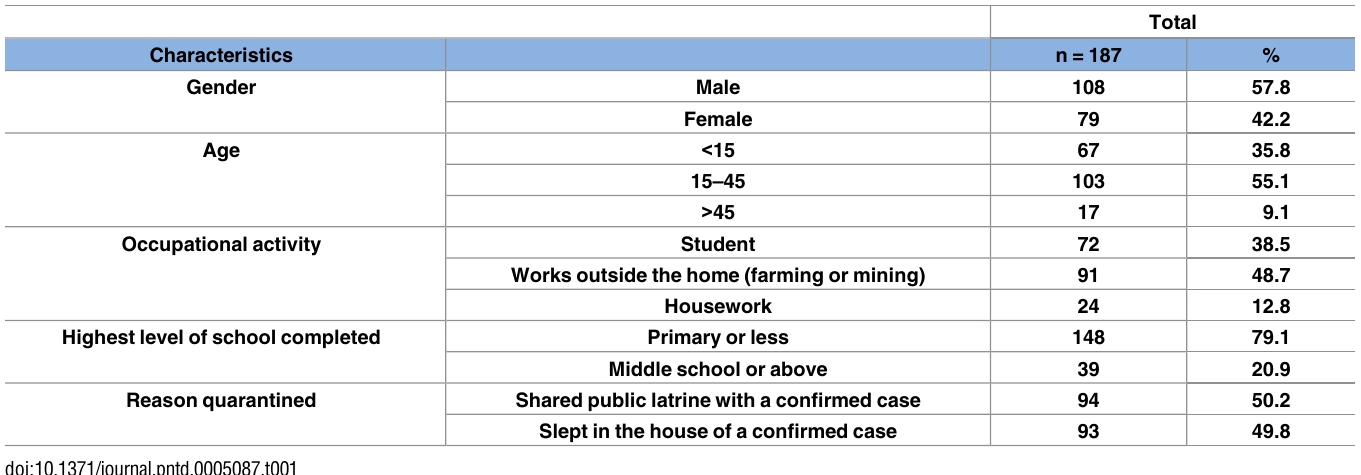
Table 1. Characteristics of researchparticipants, Sukudu, Kono District, Sierra Leone, 2015–16.